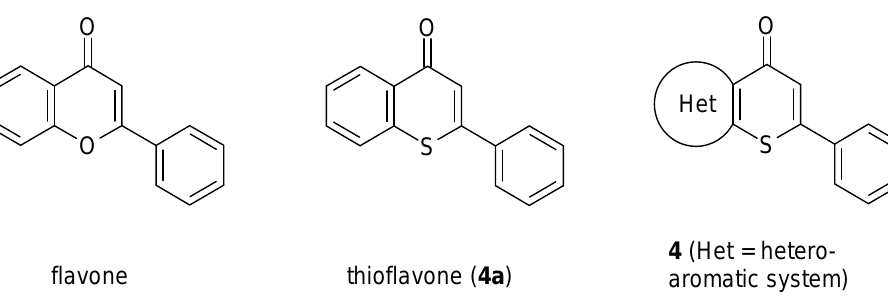
Figure 1. Flavone, thioflavone and its heterocyclic analogs 4